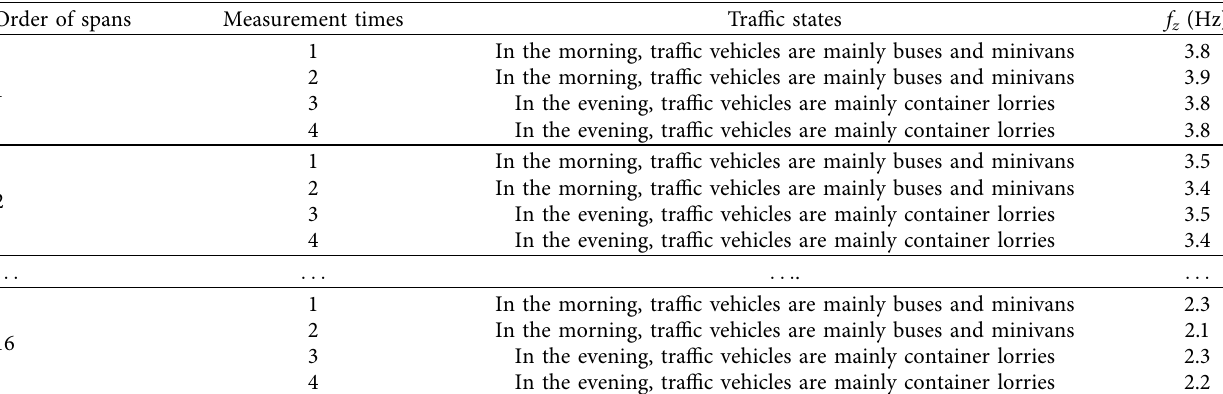
Table 16: Frequencies f